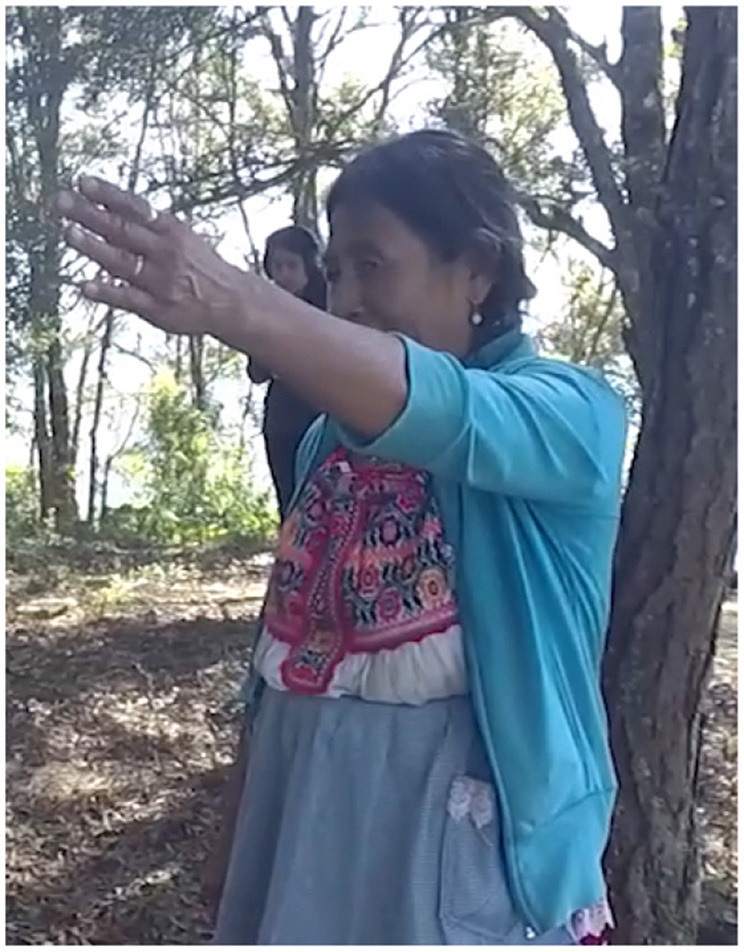
District scale [target: keA kuE suqC].